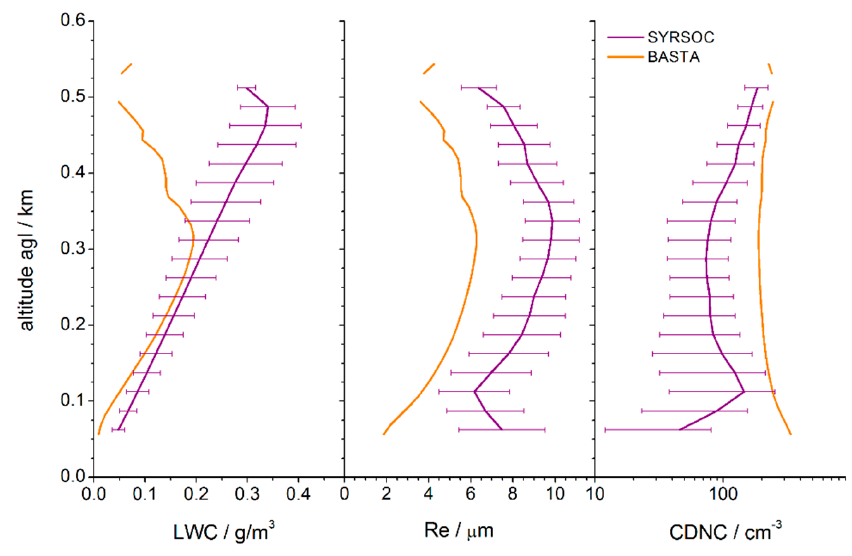
Figure 14. Vertical profile of LWC ( left ), Re ( middle ), CDNC ( right ), derived from BASTA, and SYRSOC algorithm between 08:00 and 09:00 on 19 December 2016. Error bars on SYRSOC profiles indicate standard deviation of the mean over the 1-h period.